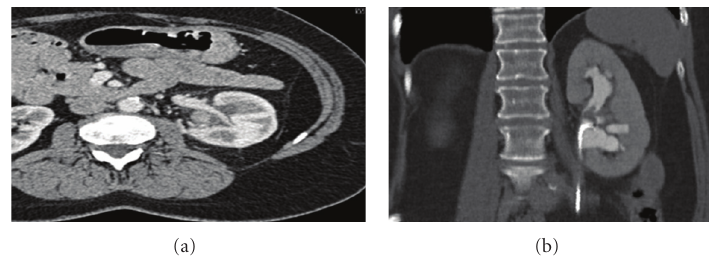
Figure 1: CT Scan findings of fibroepithelial polyp of left kidney.